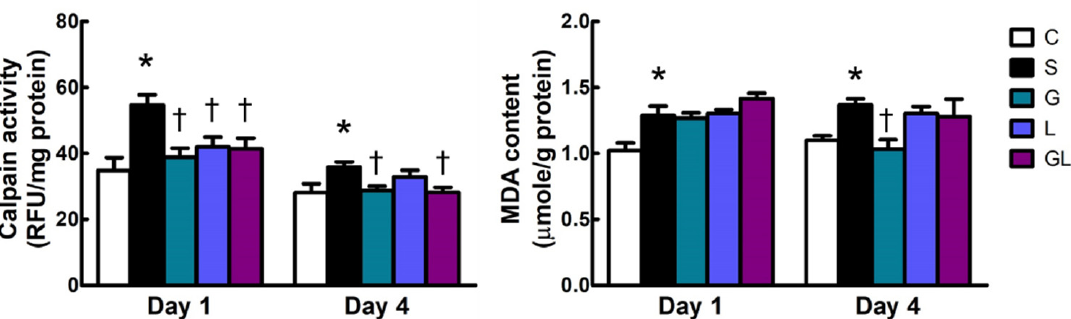
Figure 3. Calpain activity and malondialdehyde (MDA) content in muscles. The groups are described in the legend to Table 1. Student’s t -test was used to analyze differences between the C and S groups at the same time point. Differences among septic groups on the same day were analyzed by a one-way ANOVA with Tukey’s post-hoc test. * Significantly differs from the C group. † Significantly differs from the S group ( p < 0.05).